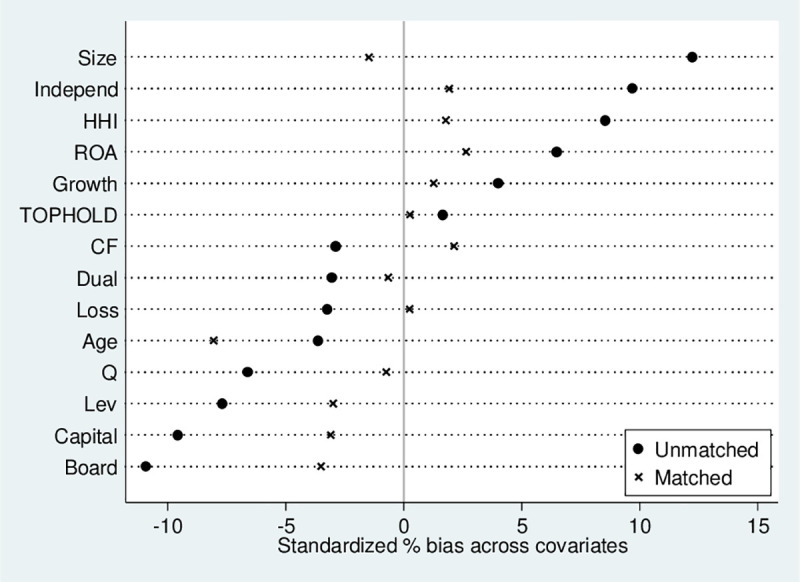
The comparison of the difference of covariates before and after matching.